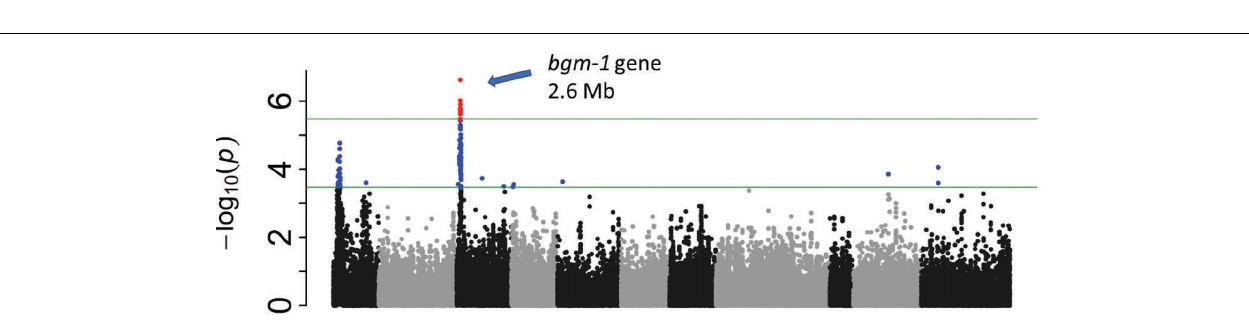
Frontiers in Plant Science |